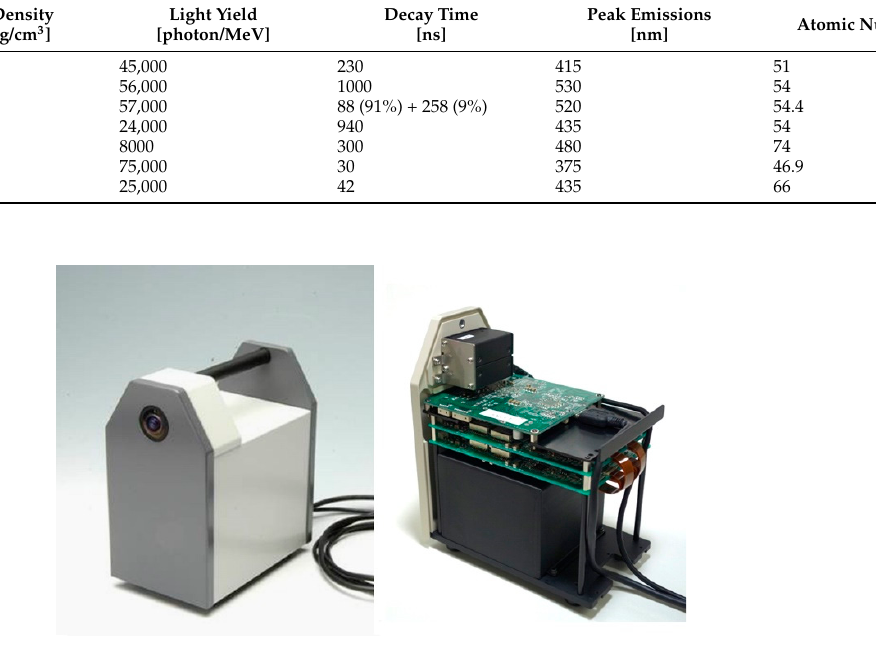
Figure 5. Ce:GAGG and MPPC based DOI handy Compton camera developed by Kataoka et al. [118]. Left photograph shows the Compton camera in compact form and the right picture shows the internal structure of the camera. Reprinted with permissions from Kataoka et al. [118].